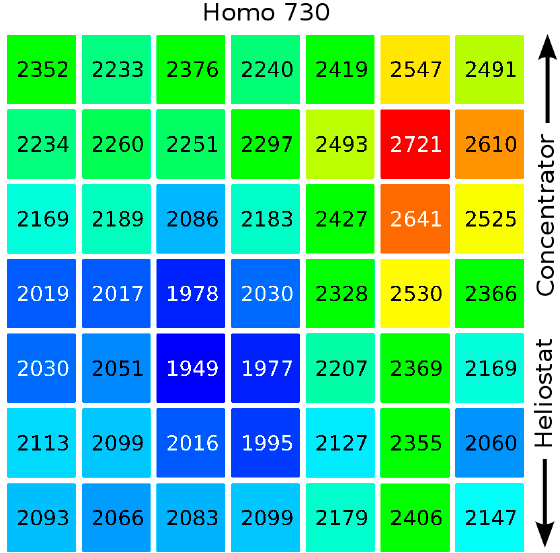
Figure 11. Energy flux (in kW / m 2 ) measured for plane z = 730 mm below the concentrator axis, after a 4-side homogeniser positioned above. The relative colour scale goes from blue (cold) to red (hot). The x axis is horizontal. The vertical y direction is aligned with the paraboloid axis, pointing above ( + y) to the paraboloid concentrator, and below ( − y) to the heliostat.